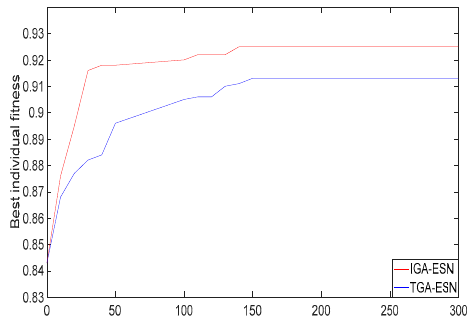
Figure 12. The best fitness curve of IGA-ESN.